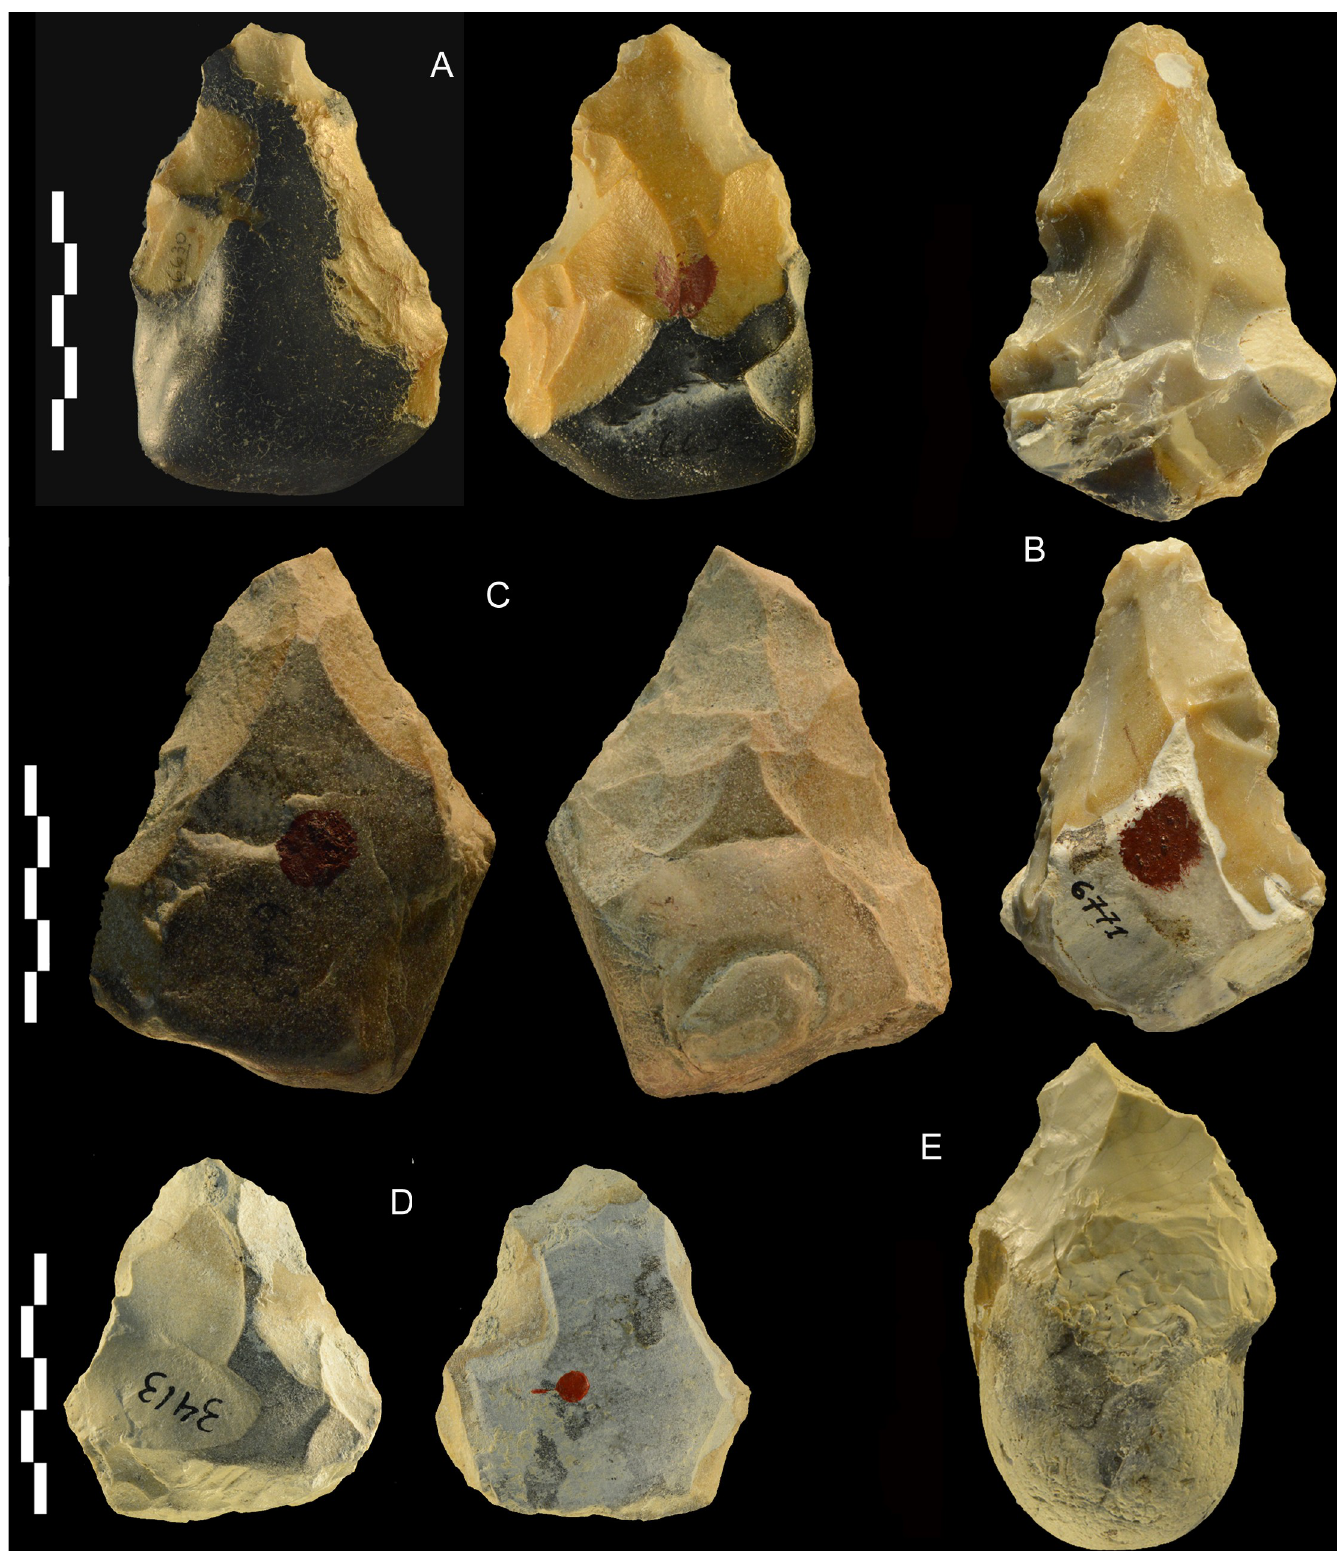
Fig 16. Castel di Guido lithics. Bifaces of flint (A, B, E) and chert (C, D). Catalogue numbers 6630, 6771, 6643, 3413, 1315. E might be considered as passing to partial biface but the lower face shows bifacial scars over half of the perimeter. A has double patina. Scale bar 5 cm. https://doi.org/10.1371/journal.pone.0256090.g016 PLOS ONE | https://doi.org/10.1371/journal.pone.0256090 August 26,